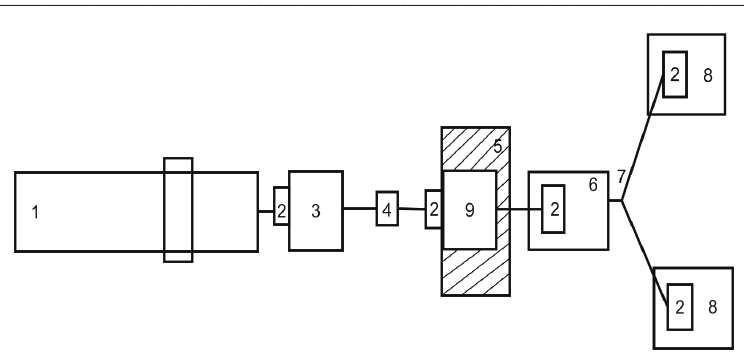
Fig. 4. Scheme of the loosening-scutching unit: 1 – Automatic stack-loosening; 2 – high-speed condenser; 3 – inclined cleaner; 4 – axial cleaner; 5 – horizontal loosening machine; 6 – mixer; 7 – serrate scutching; 8 – dedusting machine; 9 – cleaning and loosening